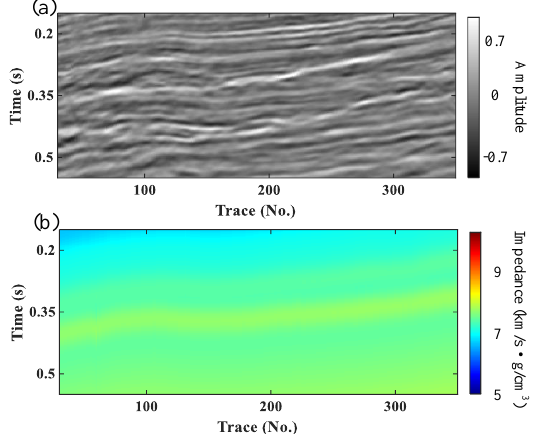
Figure 8. Real data test: ( a ) Original seismic records. ( b ) Initial impedance model.